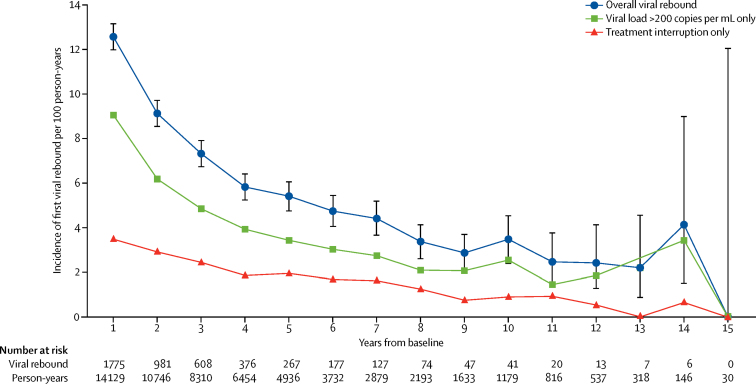
Incidence of first viral rebound by time since study baseline (9 months after start of ART)Error bars show 95% CI.